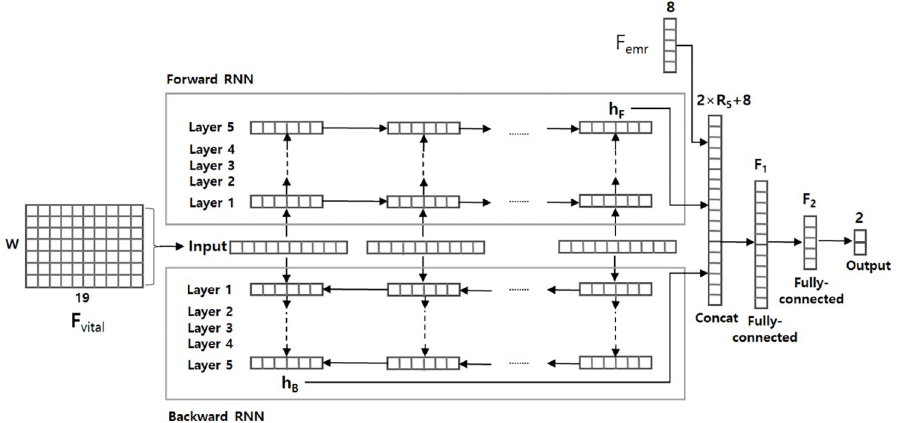
Fig 3. Recurrent neural network (RNN)-based model